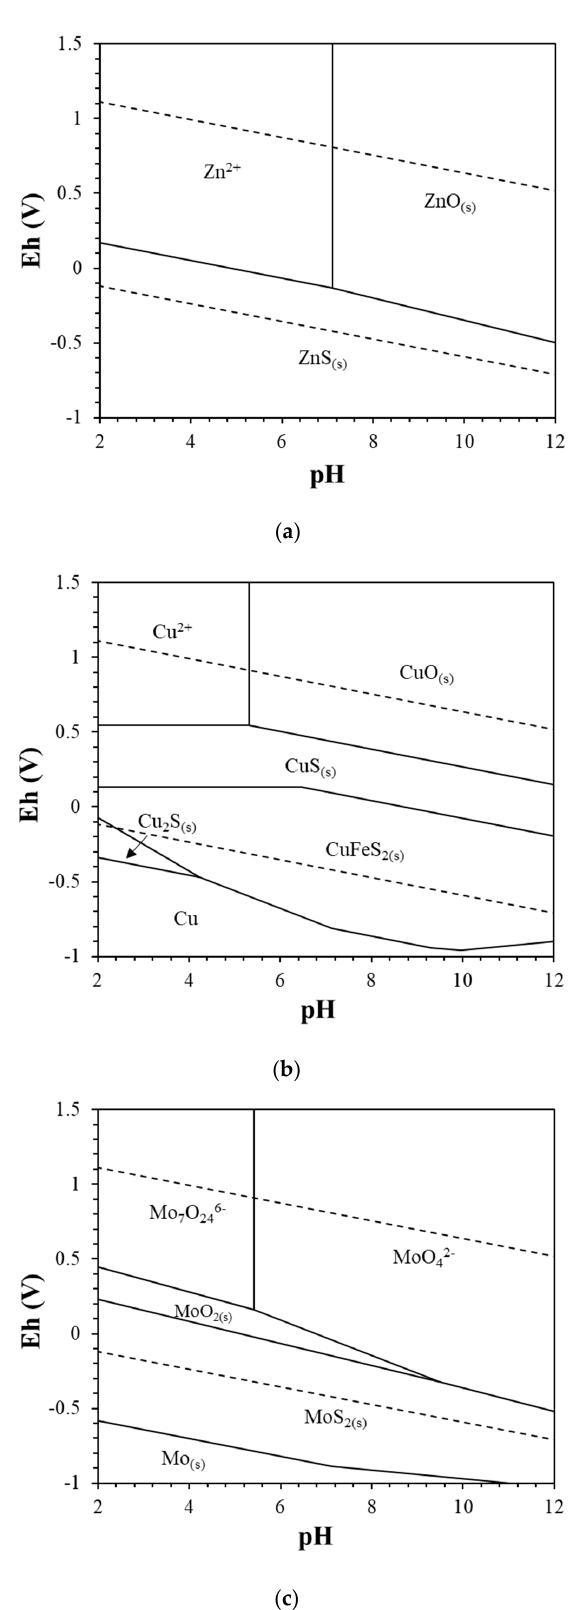
pulp density: 5%, temperature: 25 °C, pH 9, ultrasonic power: 27 W).